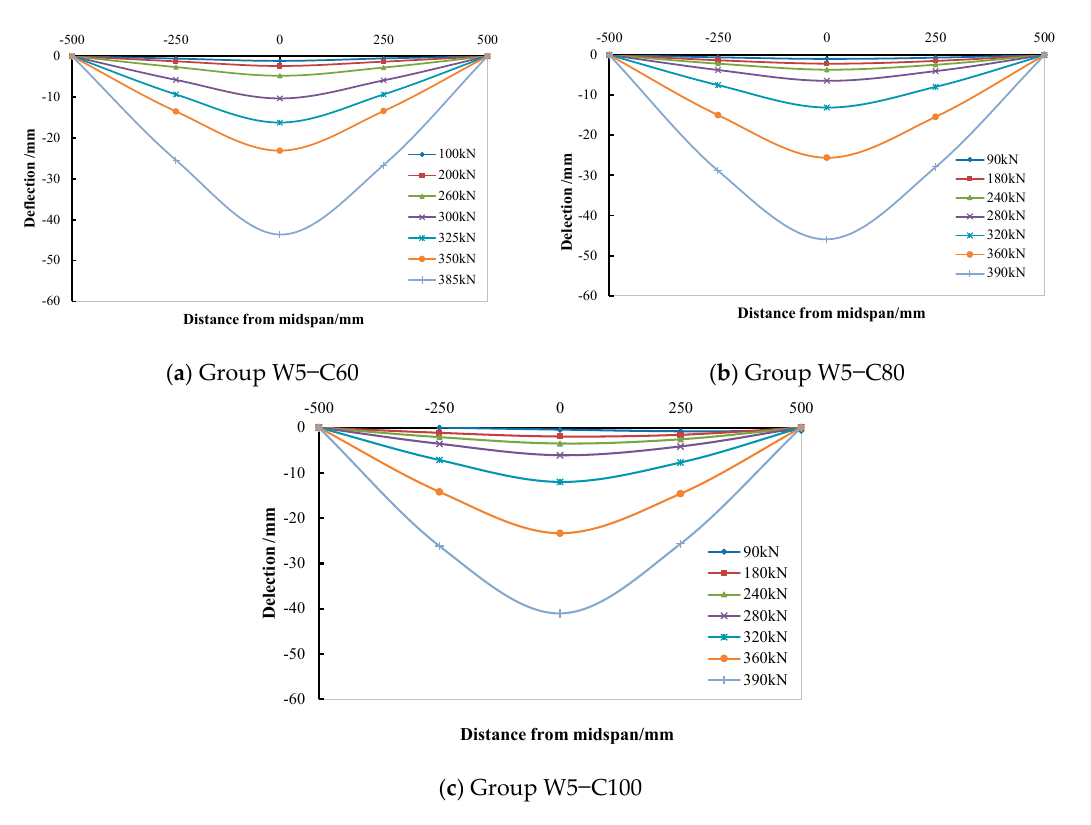
Figure 10. Deflection along the specimen length.